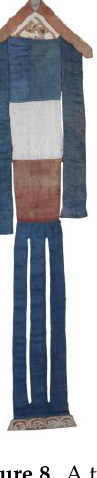
Figure 8. A typical Buddhist Banner, 7th to 10th century, pattern and plain woven silk, wood, and paint, H. 131.0 cm, W. 34.0 cm, LOAN:STEIN.619, Victoria and Albert Museum. © Victoria and Albert Museum, London.